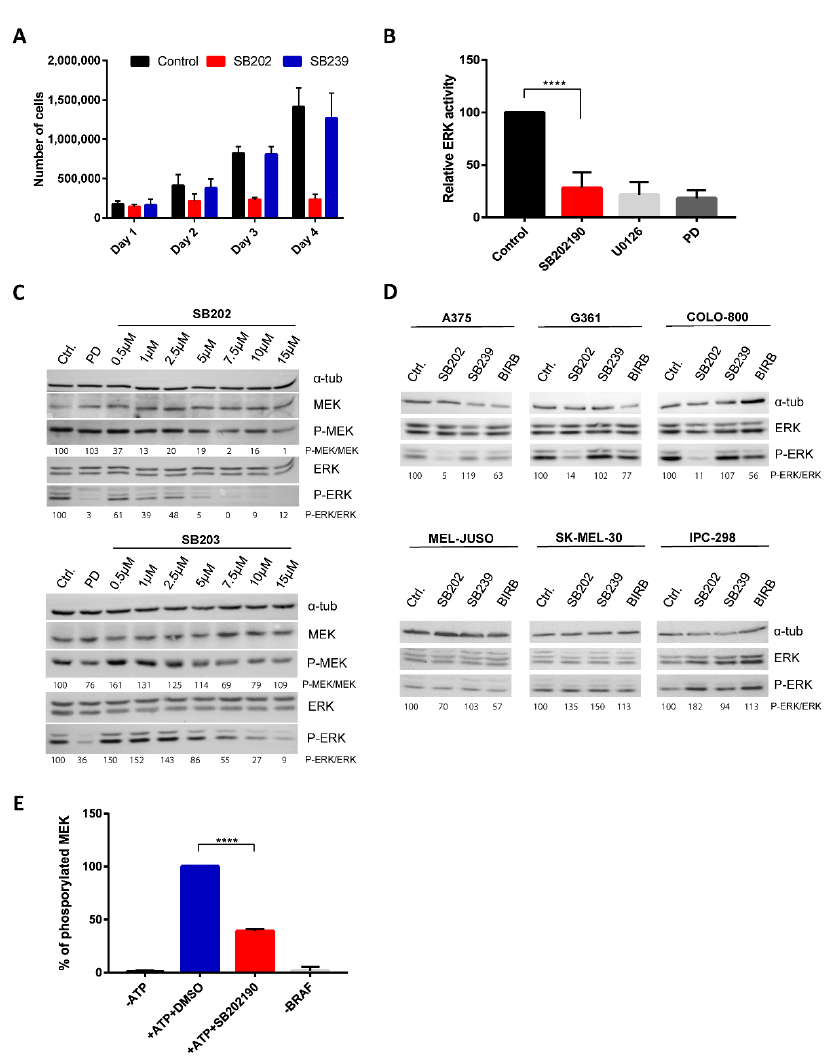
Figure 1. Pyridinyl imidazole p38 mitogen-activated protein kinase (MAPK) inhibitors SB202190 and SB203580 disrupt mutant BRAF kinase activity in human melanoma cells. ( A ) The proliferation of A375 cells was measured by flow cytometry during 4-day cultivation. The number of cells was